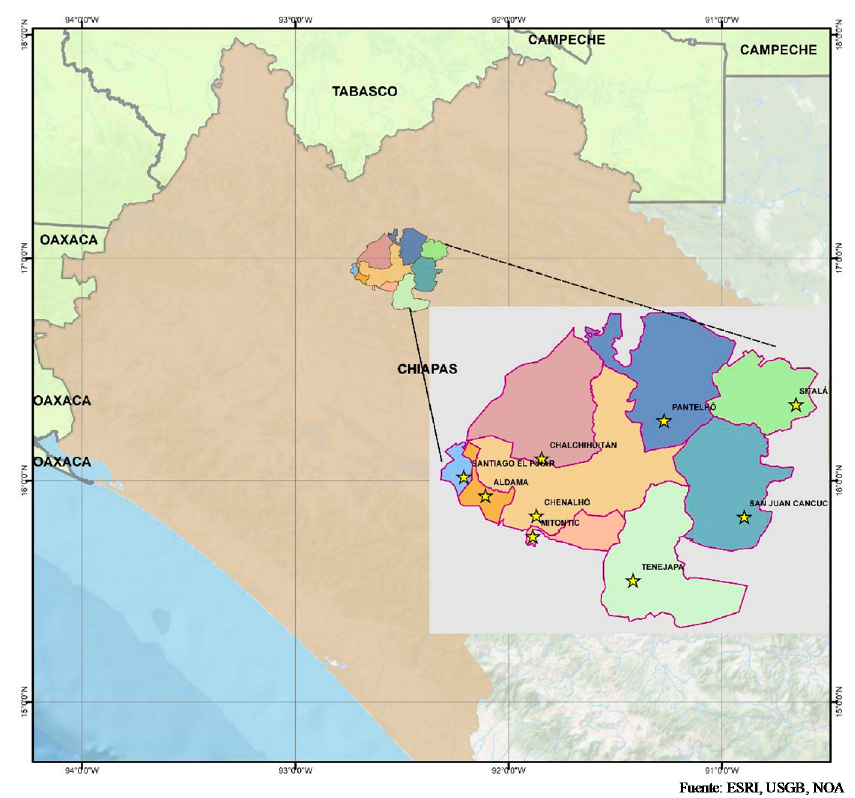
Figure 3. Map of Los Altos Municipality, State of Chiapas,